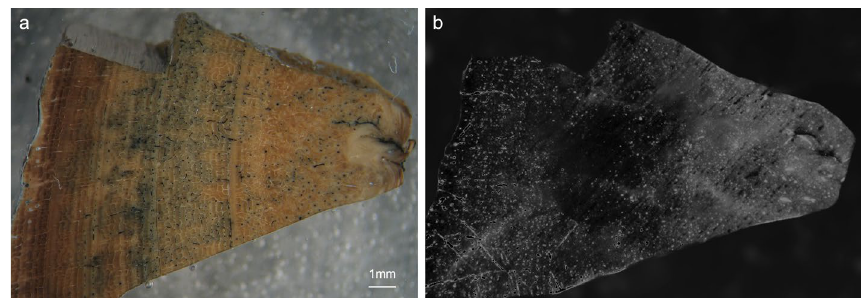
Figure 2. Stereomicroscope (left) and CL (right) images of the investigated sample FK BI RS 1 (1.25 × magnification). Outer surface is on the left and the inner part is on the right. Image 2a has been taken by L.G. following the protocol reported in the “Materials and methods”